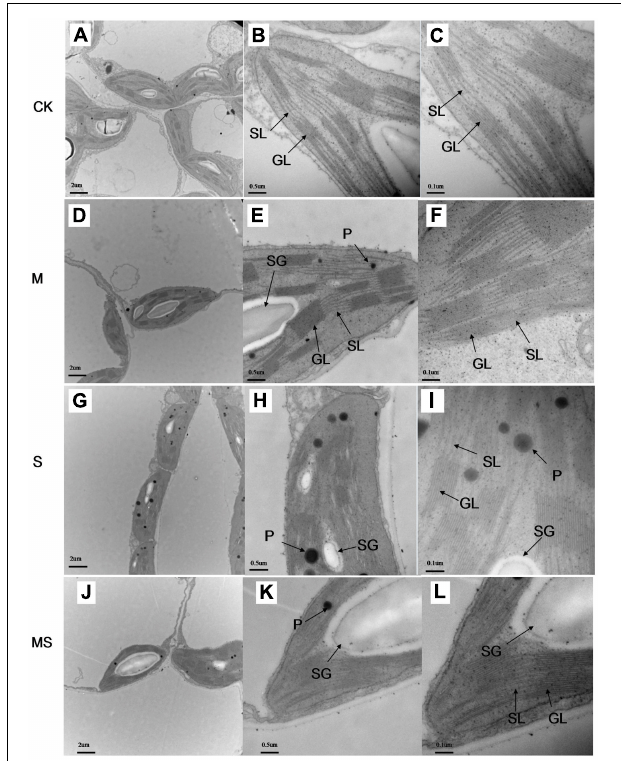
FIGURE 5 | Chloroplast ultrastructure in watermelon inoculated or non-inoculated seedlings with AMF Funneliformis mosseae and subjected or not to salinity-alkalinity stress. (A) Mesophyll cells in CK; (B) chloroplast in CK; (C) thylakoid in CK. (D) ; mesophyll cells in M; (E) chloroplast in M; (F) chloroplast in M; (G) mesophyll cells in S; (H) chloroplast in S; (I) thylakoid in S; (J) mesophyll cells in MS; (K) chloroplast in MS; (L) chloroplast in MS. AMF, arbuscular mycorrhizal fungi; CK, without AM inoculation + without salinity-alkalinity; M, with AM inoculation + without salinity-alkalinity; S, without AM inoculation + with salinity-alkalinity; and MS, with AM inoculation + with salinity-alkalinity. Data were obtained from the second expanded leaves (numbered basipetally) after salinity-alkalinity treatment for 8 days. SL, stroma lamellae; GL, grana lamellae; SG, starch grains; P, plastoglobuli. Scale bars for chloroplasts and thylakoids are 2, 0.5, and 0.1 µ m,